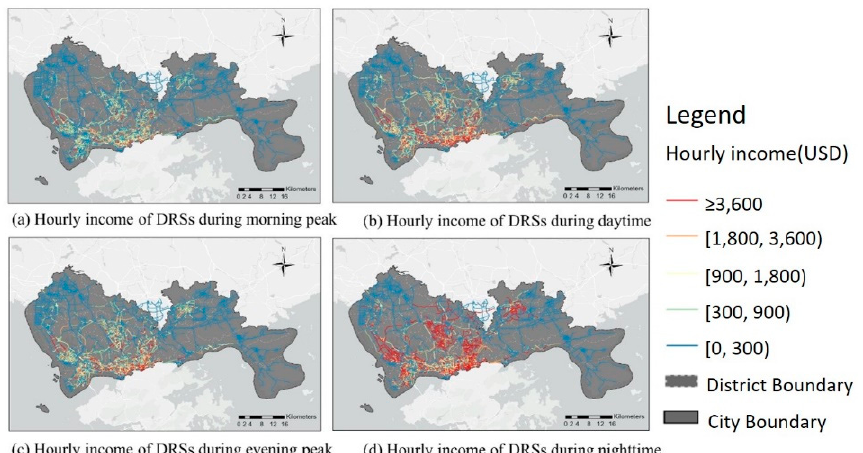
Figure 8. Spatial distributions of incomes (the source of the geographical background is Mapbox).